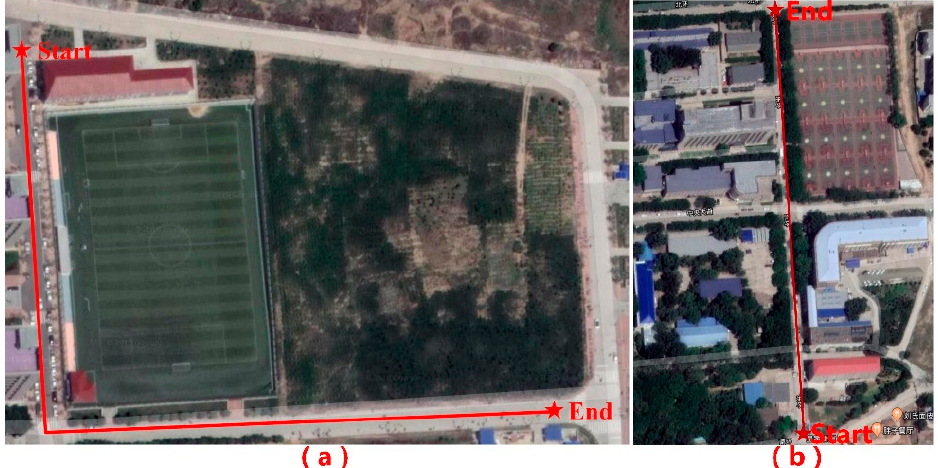
Figure 7. Experiment place and trajectory. ( a ) The first experiment; ( b ) The second experiment.